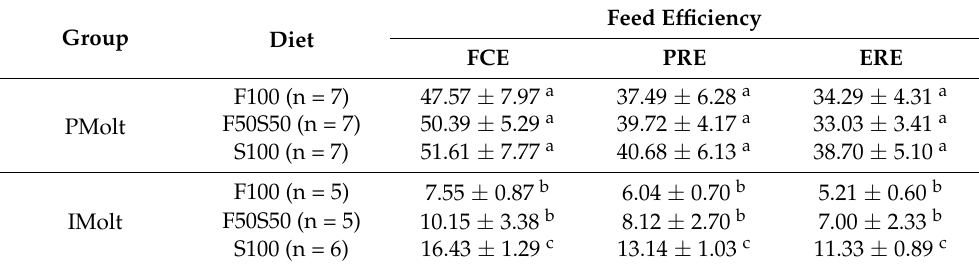
Table 5. Adjusted mean values of efficiency in feed conversion (FCE), protein retention (PRE) and energy retention (ERE) at the optimal feed intake for crab groups, PMolt and IMolt, fed on three different diets.